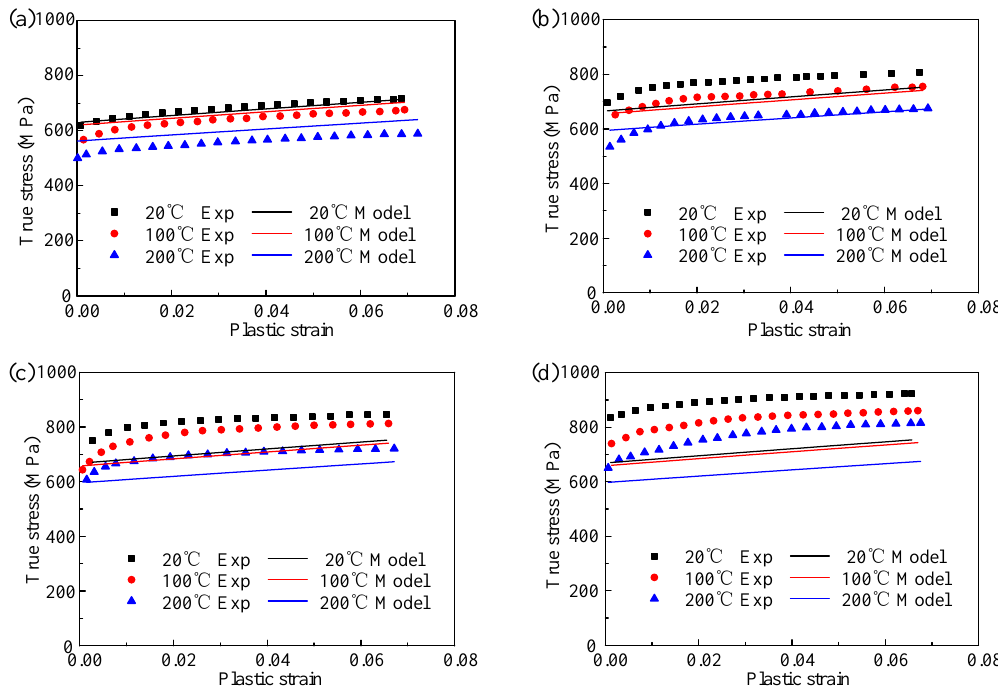
Figure 7. Comparison between experiment result and the predicted flow stress by JC model for orthogonal cutting experiment at different strain rate of ( a ) 0.001 s −1 , ( b )1000 s −1 , ( c ) 3000 s −1 , and ( d ) 5000 s −1 . Table 3. The material constant of JC model obtained by orthogonal cutting experiment [29].